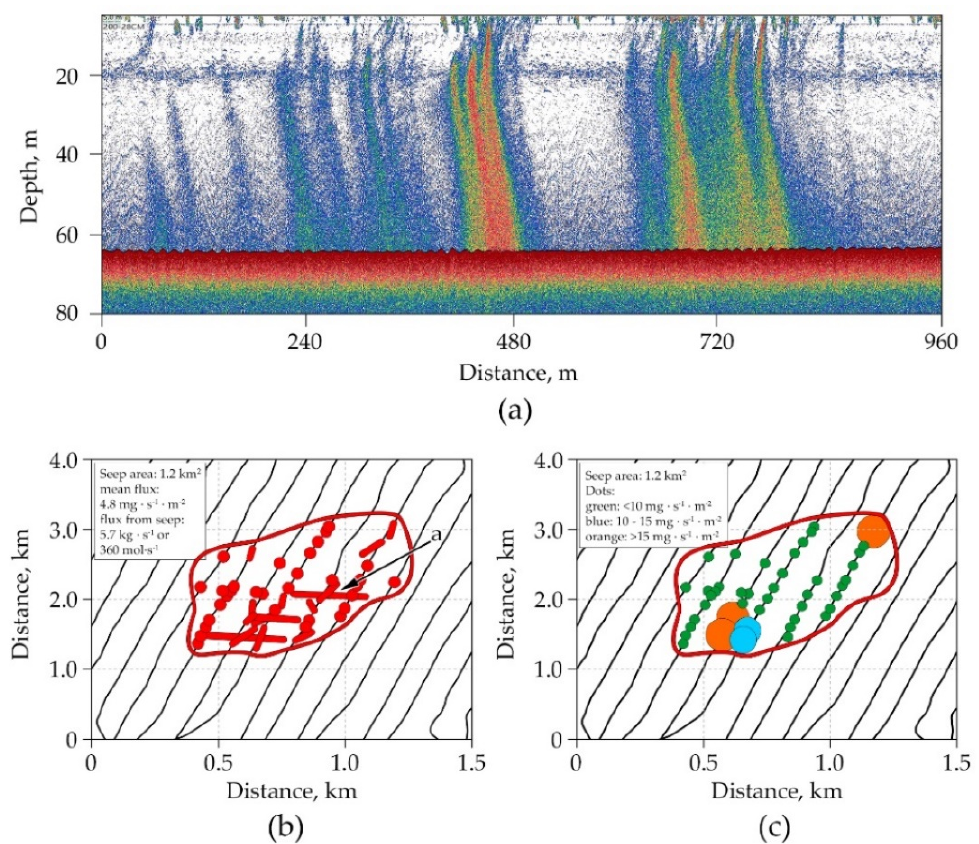
Figure 6. Singlebeam sonar image of a large seep in the Laptev Sea ( a ); location of methane seeps in the zone of ebullition (red dots) and Research Vessel tracks (black lines) tracks. Red lines show >100 m seeps ( b ); amount of methane released by each seep ( c ).